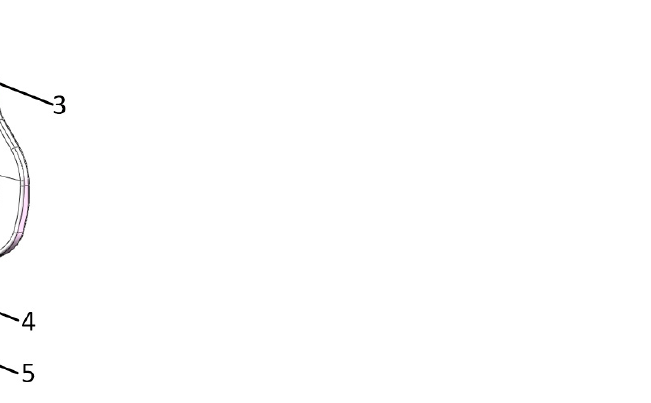
Figure 7. Structure of base plate: 1—notches; 2—S-shaped brackets; 3—balanced shoulders; 4– balanced supporters; and 5—chain connector.